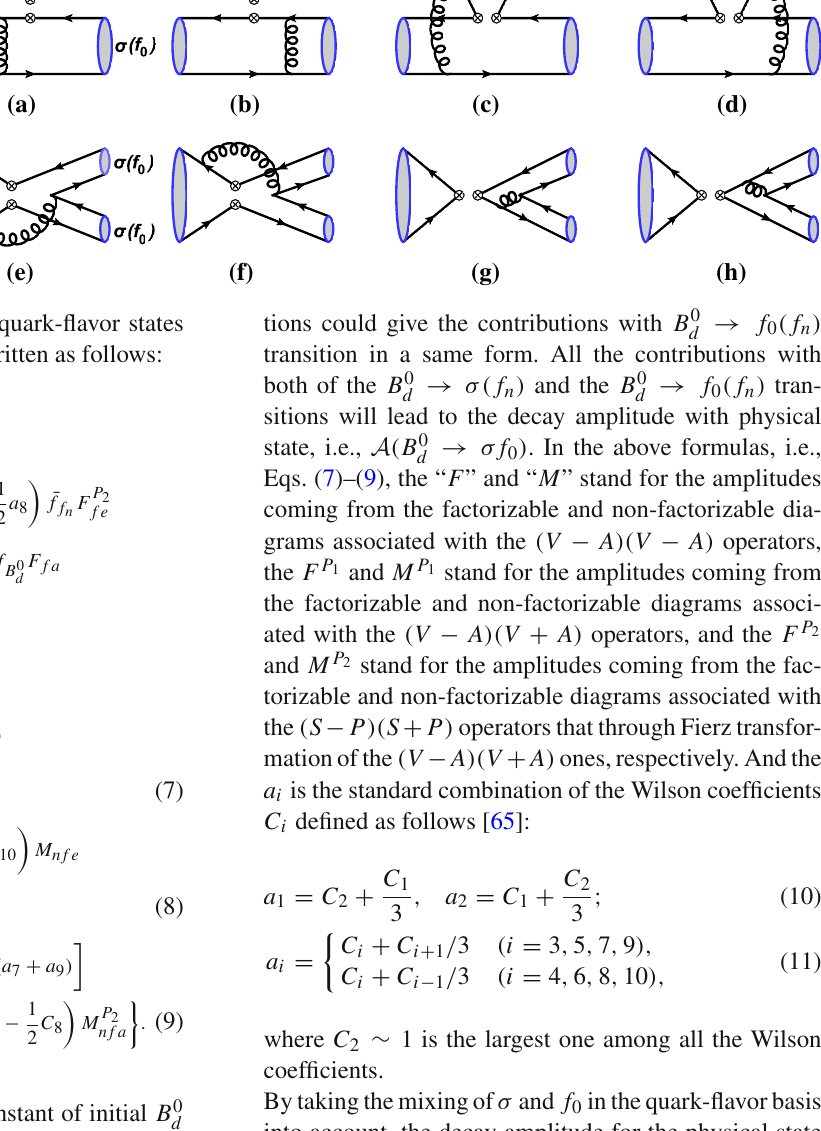
Fig. 1 Leading order Feynman diagrams for the neutral B -meson decays into σσ,σ f 0 , and f 0 f 0 within the framework of